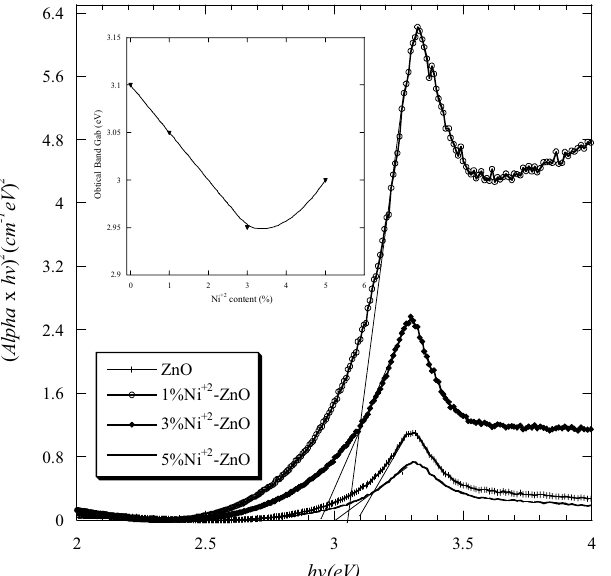
2 Figure 7. (α h ν) versus the photon energy ( h ν ) of pure and Ni doped ZnO nanopowders. The inset is the energy gap of samples as a function of Ni content.